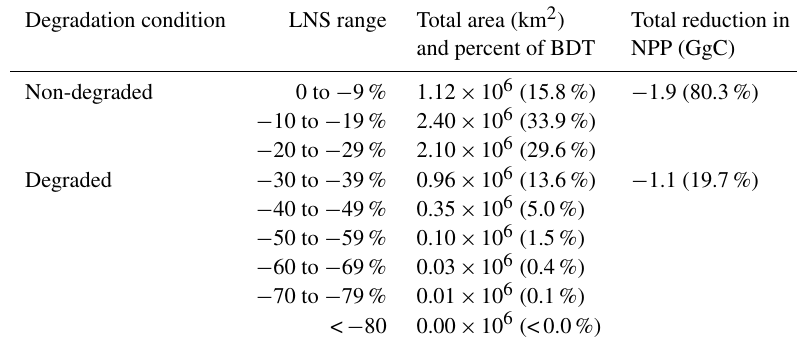
Table 3. Area and percentage of Burdekin Dry Tropics in each LNS range.